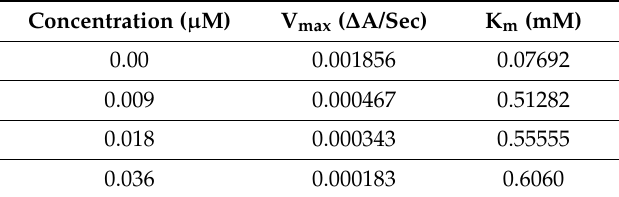
Table 2. Kinetic parameters of the acetylcholine esterase from human erythrocytes for acetylthiocholine iodide activity in the presence of different concentrations of 3b.